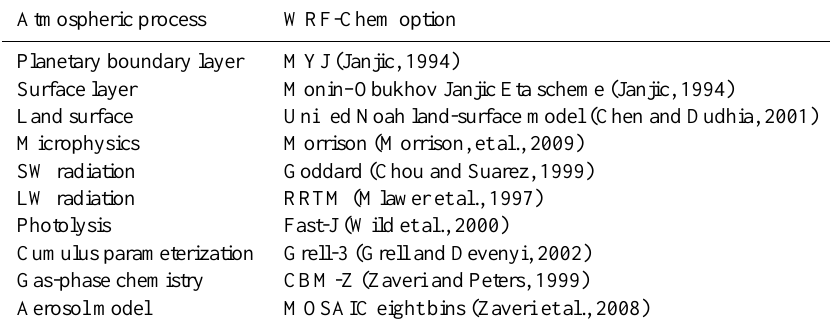
Table 1. Parameterizations and options used for the WRF-Chem